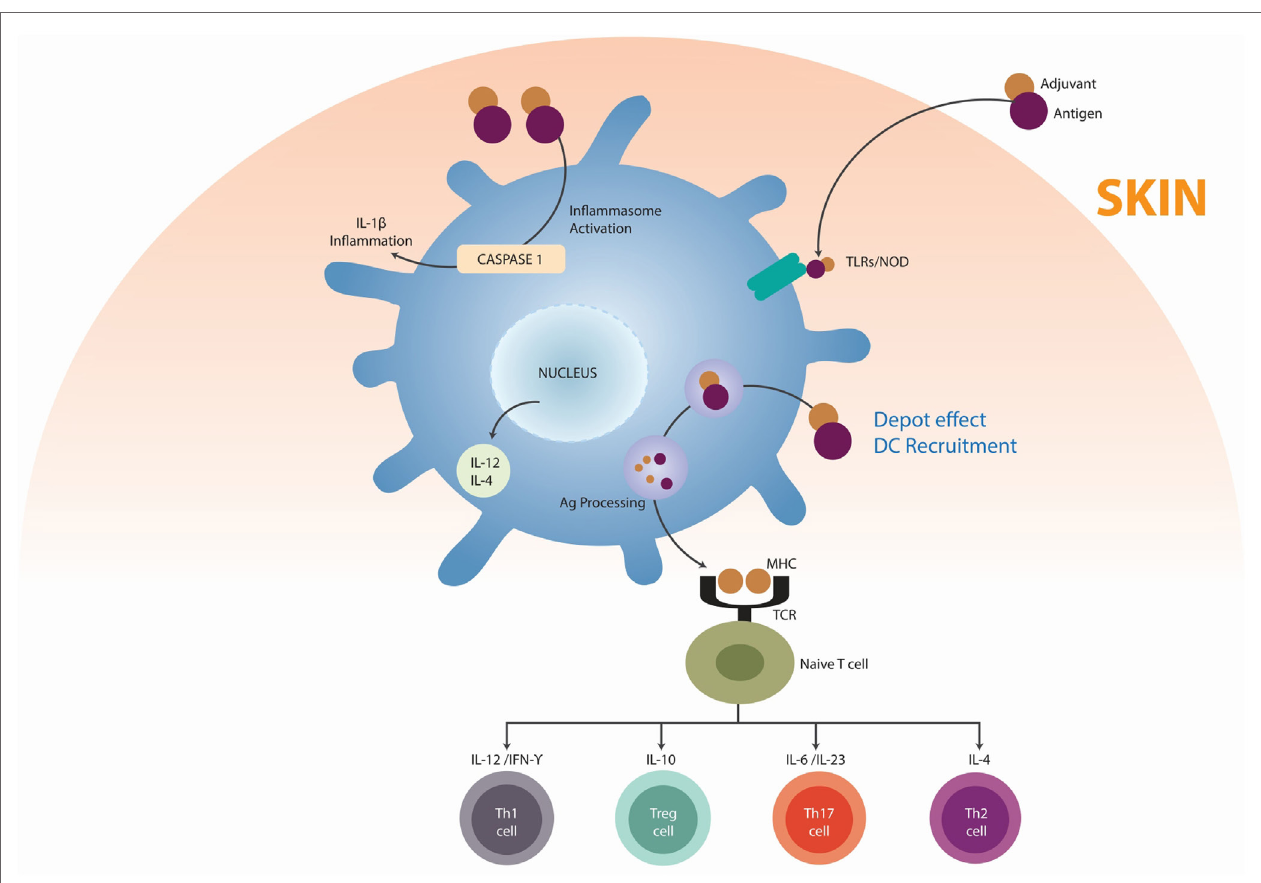
FiGURe 4 | Mechanisms by which adjuvants trigger autoimmunity . Adjuvants (mainly alum) may function as delivery systems by generating depots that trap antigens at the injection site, providing slow release in order to continue the stimulation of the immune system, thus enhancing the antigen persistence and increasing recruitment and activation of dendritic cells (DC) (depot’s effect). Other adjuvants, essentially ligands for pattern recognition receptors (PRR), act by inducing the innate immunity by targeting the DC via toll-like receptors (TLRs). Adjuvants can direct support antigen presentation by the major histocompatibility complexes (MHC), inducing the differentiation of a naïve T cell in T helper 1 cells (Th1), T helper 2 cells (Th2), T regulatory cells (Treg), and T helper 17 cells (Th17). Adapted from Ref.